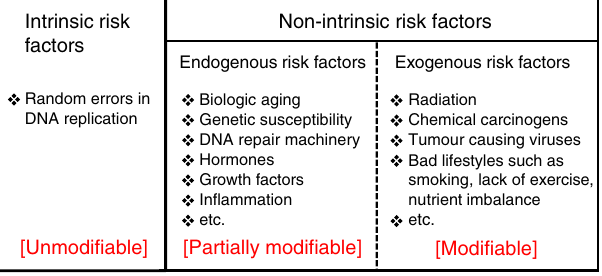
Fig. 1 Three types of cancer risk factors. The overall cancer risk factors are divided into two mutually exclusive components: the unmodi fi able intrinsic and the modi fi able, at least partially, non-intrinsic risk factors. The intrinsic risk factors refer to random errors resulting from DNA replication. The non- intrinsic risk factors further consist of endogenous and exogenous risk factors depending on whether such factors are more internal or